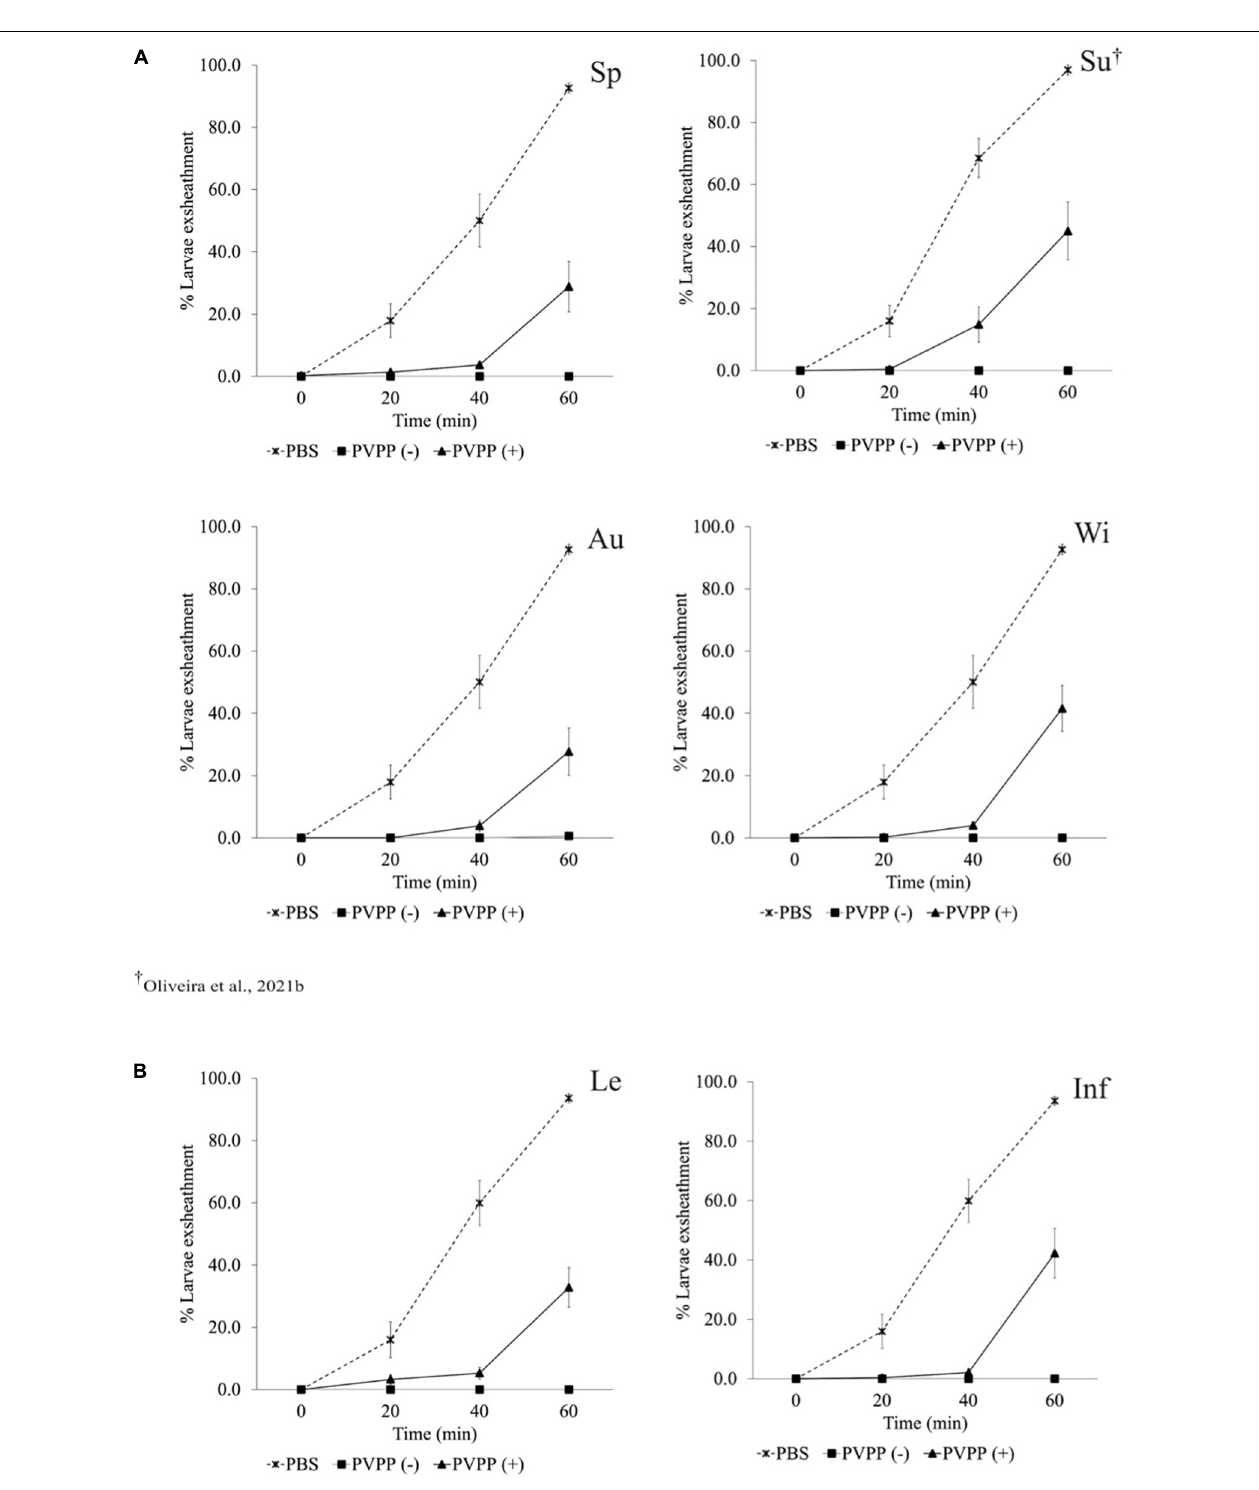
FIGURE 2 | Anthelmintic effects of Cladium mariscus (L.) Pohl (sawgrass) seasonal (A) and organ (B) extracts, on LEIA for Haemonchus contortus at the concentration of 1,200 µ g mL − 1 , either treated [PVPP(+)] or not [PVPP(-)] with PVPP. Sp, spring; Su, summer; Au, autumn; Wi, winter; Le, leaves; Inf, inflorescences.